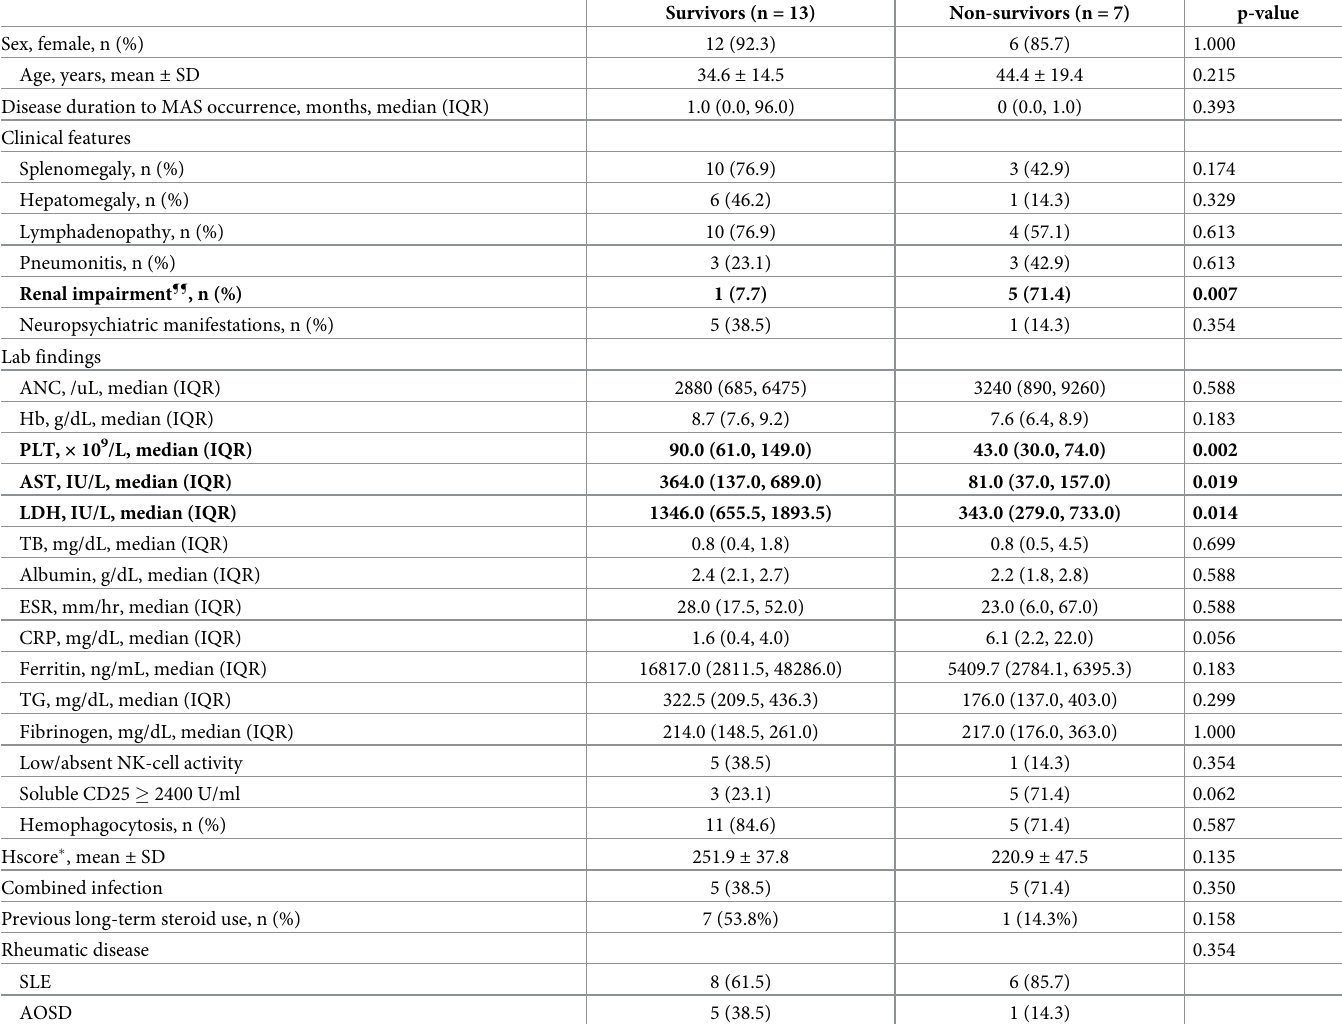
Table 4. Comparison of characteristics between survivors and non-survivors in patients with